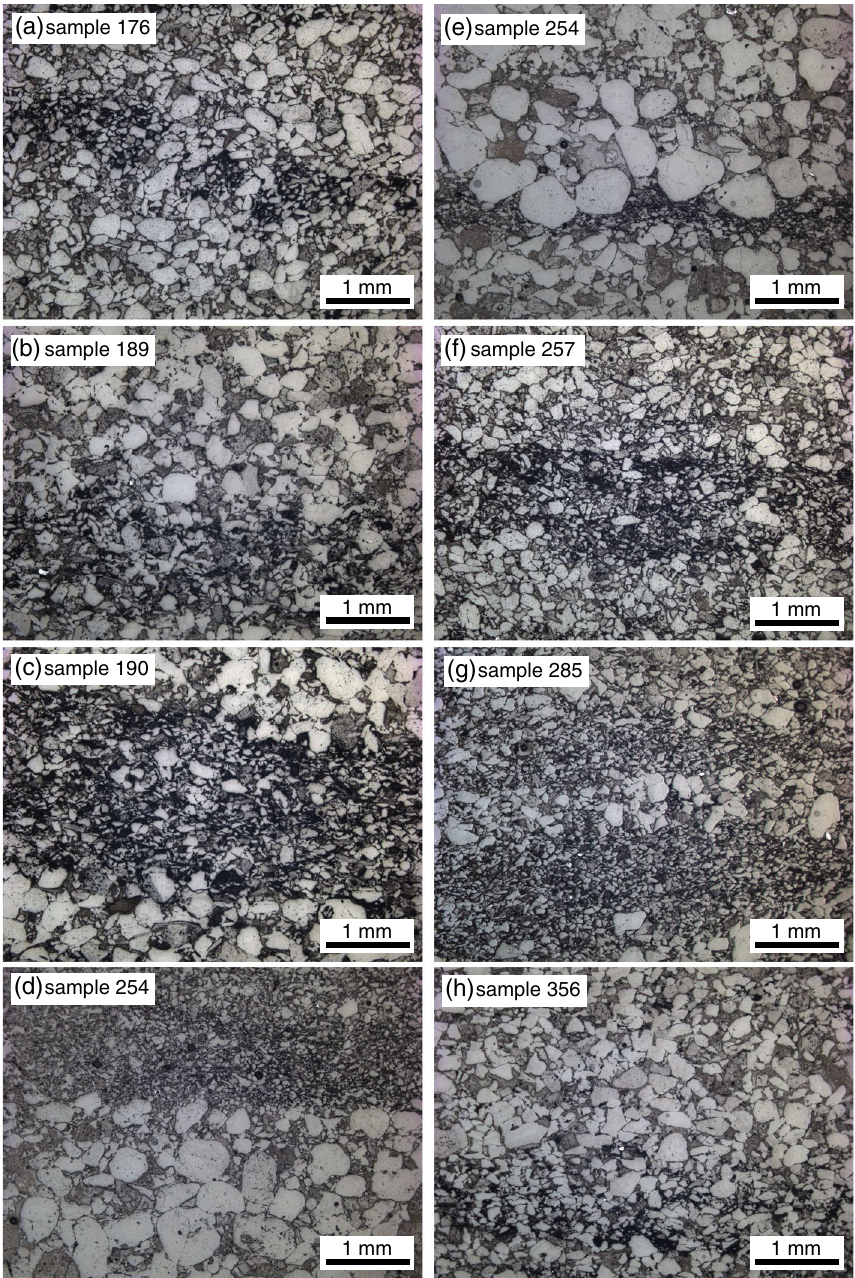
Fig. 5 Microstructural images of the seven cores investigated in this study (shown in Fig. 3) taken using an optical microscope under reflected light. a Sample 176. b Sample 189. c Sample 190. d Sample 254. e Sample 254. f Sample 257. g Sample 285. h Sample